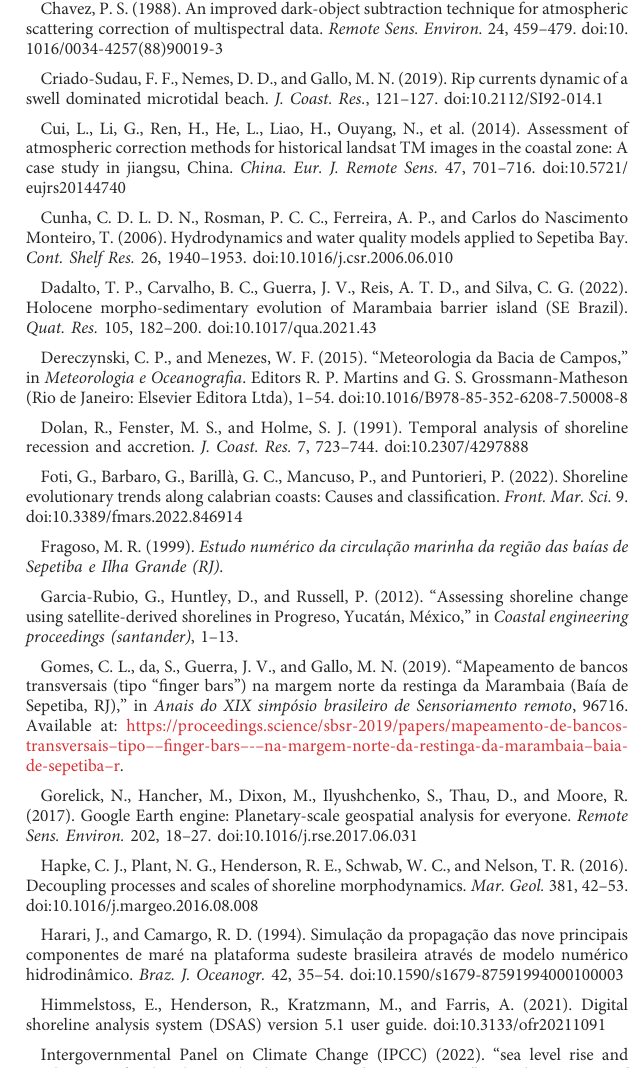
SUPPLEMENTARY FIGURE S1 Temporal distribution of landsat imagery (DOY: Day Of Year). SUPPLEMENTARY FIGURE S2 Monthly averaged air temperature and accumulated precipitation from Marambaia metereological station (2002 to 2021), located at43 ° 36 ʹ W and 23 ° 03 ʹ S. Data provided by the National Institute of Meteorology